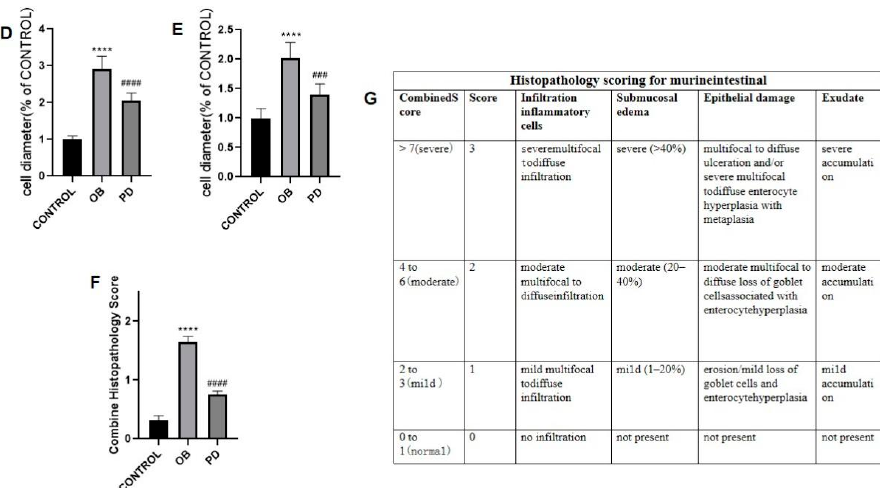
Figure 2. PD improved fat accumulation and enhanced intestinal barrier integrity in ob/ob mice (200×). PD alleviated morphology changes of ( A ) SWAT and ( B ) BWAT in ob/ob mice; ( C ) PD ame-